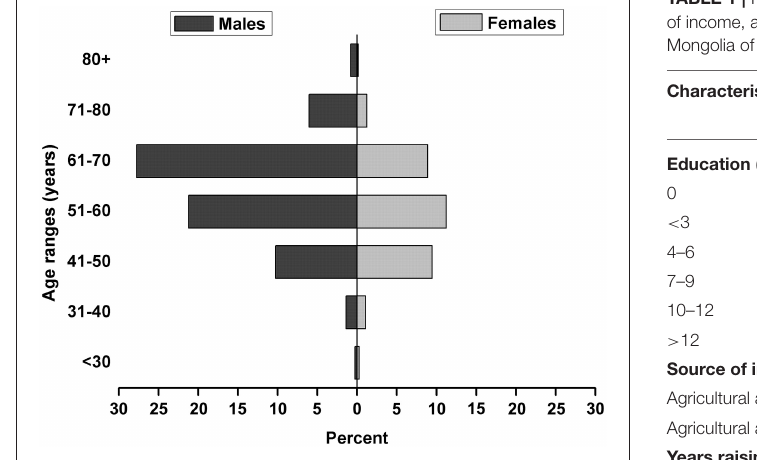
FIGURE 1 | Age and gender distributions of the donkey owners in Western Liaoning and Eastern Inner Mongolia of China ( n = 731).